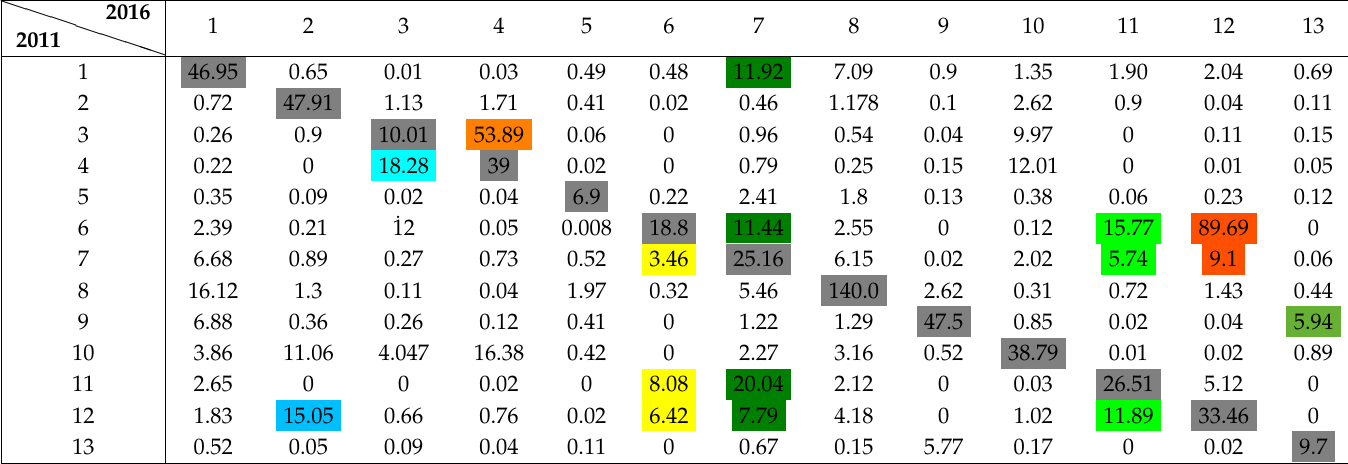
Table A2. Land use transition of Phuoc The from 2011 to 2016 (unit: ha) of 13 land use types. Gray represents unchanged land types; other colors refer to significant changes of some specific land types shown in Figure